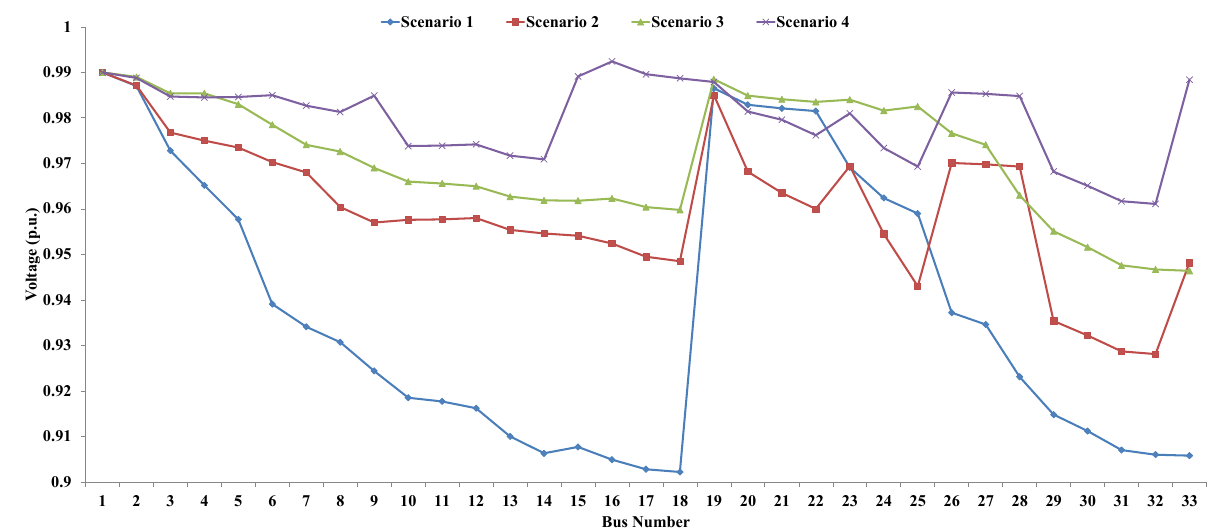
Figure 7. Voltage profiles of IEEE-33 bus system with different scenarios.